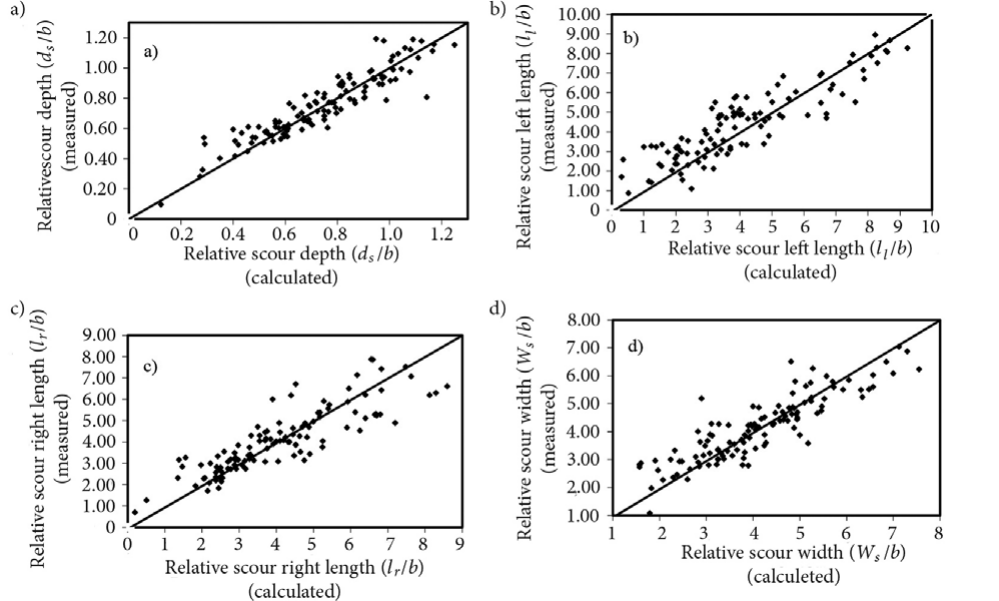
Figure 11. The predicted vs calculated scour hole